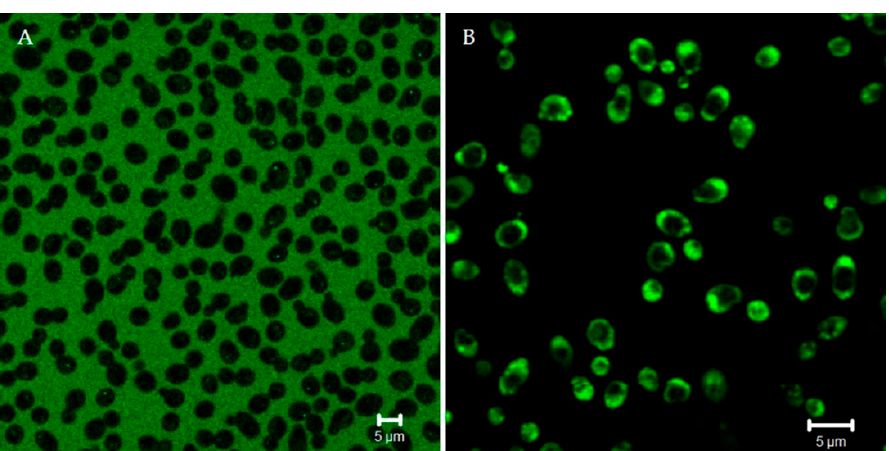
Figure 2. Confocal microscopy images of living Candida albicans cells treated for 15 min with the fluorescein isothiocyanate- labeled Ab gene-peptide L12P ( A ). The peptide was on the yeast cell surface and entered into yeast cells within a few minutes; empty vacuoles were seen. Some yeast cells were no longer viable, as assessed by propidium iodide internaliza- tion ( B ). ( C ) merge of panels A and B. Bar: 2 µm. The rapidity of the killing effect suggests a membrane-disrupting mode of action.